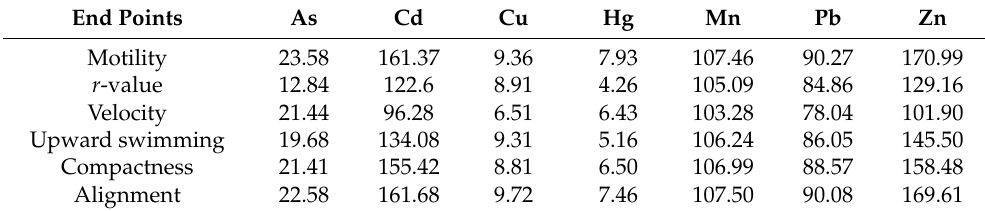
Table 1. EC 50 values (mg L − 1 ) of seven metals with different end points in Euglena agilis . End